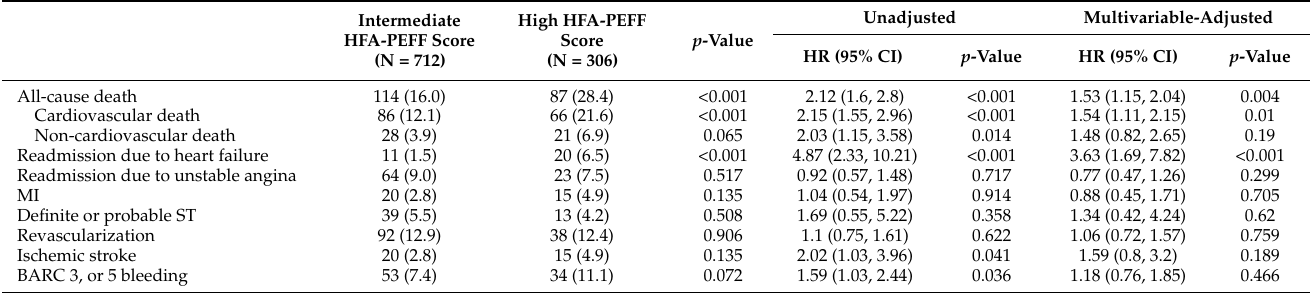
Figure 2. Cumulative incidence of all-cause mortality according to HFA-PEFF scores. Table 4. Clinical outcomes according to the HFA-PEFF score in patients with AMI suspected of